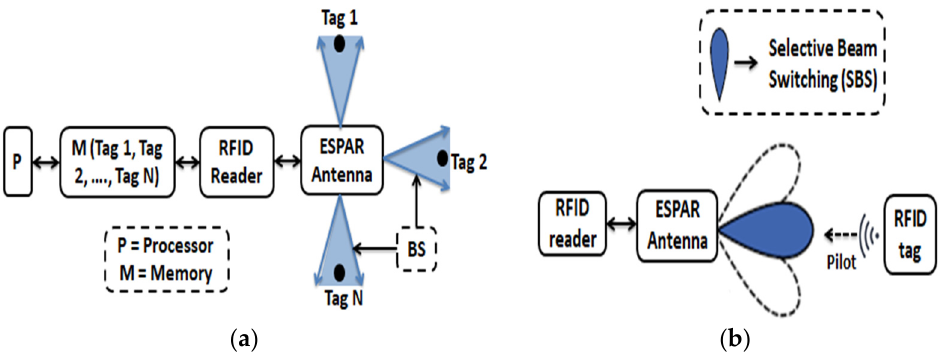
Figure 9. ( a ) BSM for the RFID sensor networks; ( b ) SBS at a particular direction of the RFID